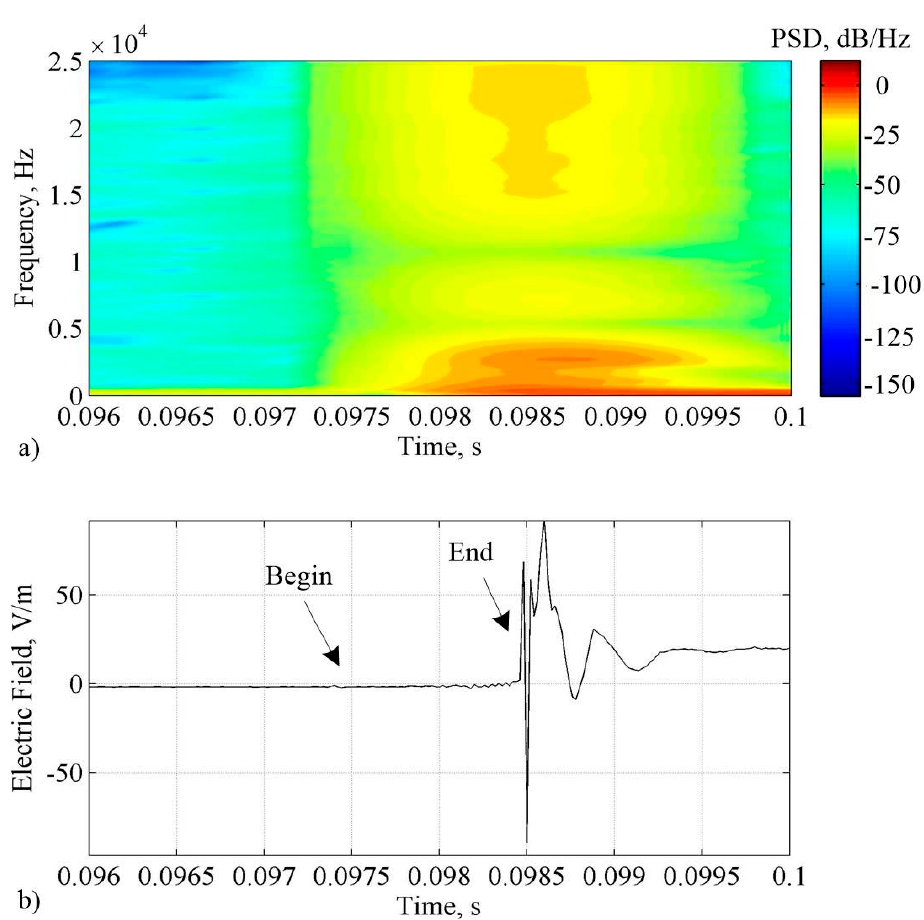
Figure 9. Description is the same as in Figure 8, except for the detection of another positive lightning leader stage at a very far distance to the lightning channel and which corresponds to Case #12 given in Table 1.